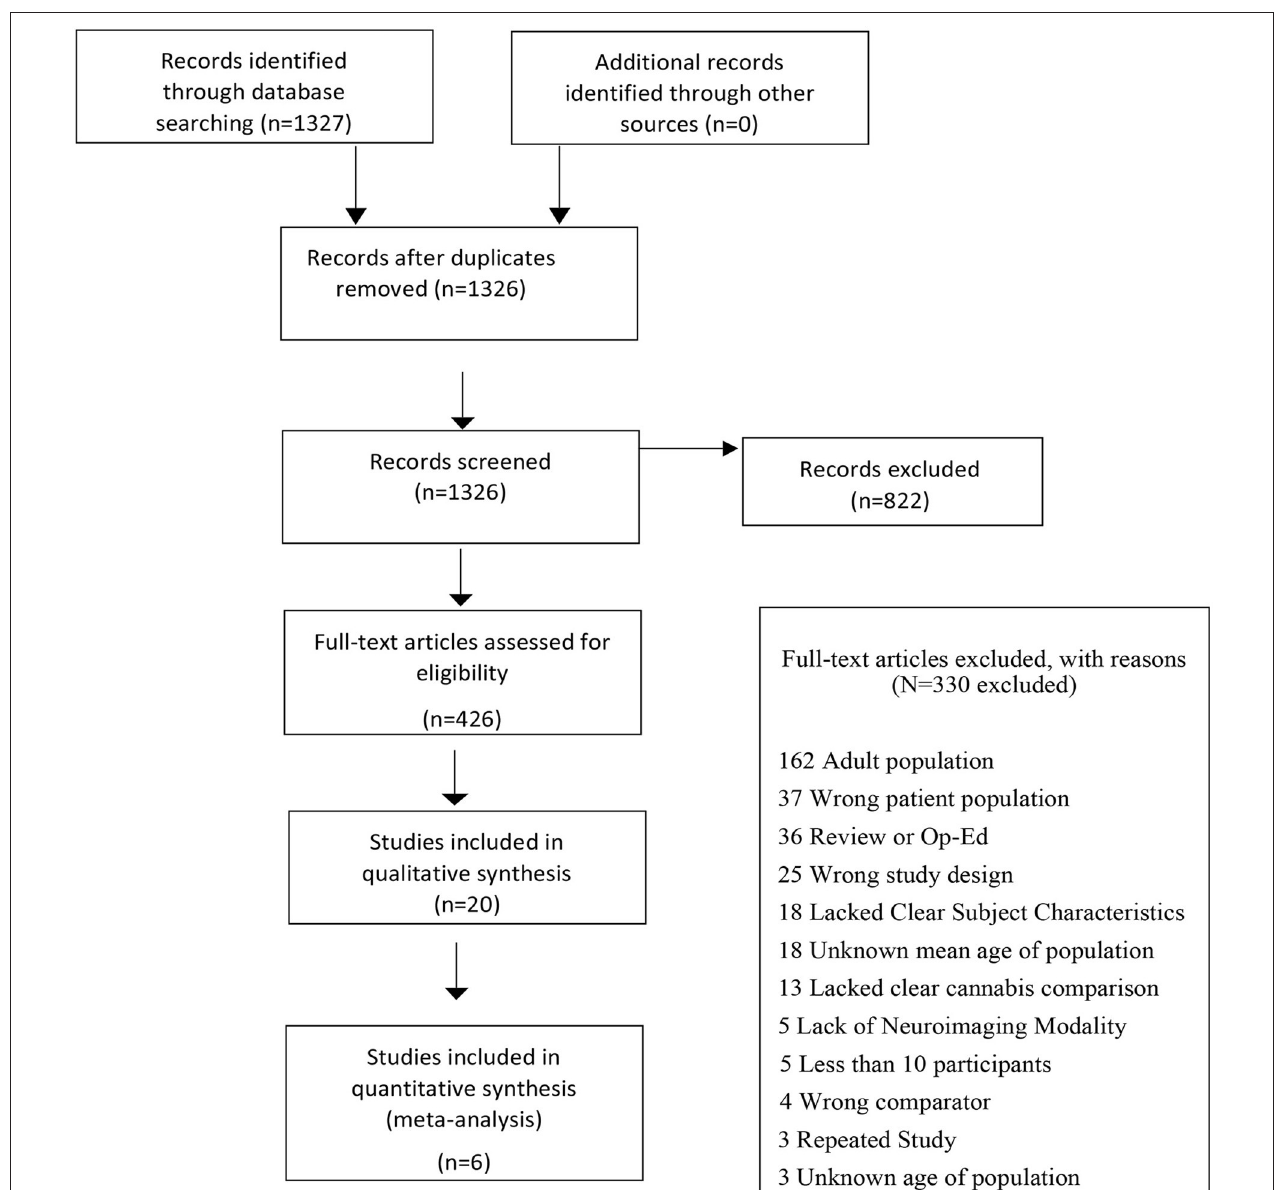
FIGURE 1 | Flowchart outlining selection procedure of studies of GMV differences.